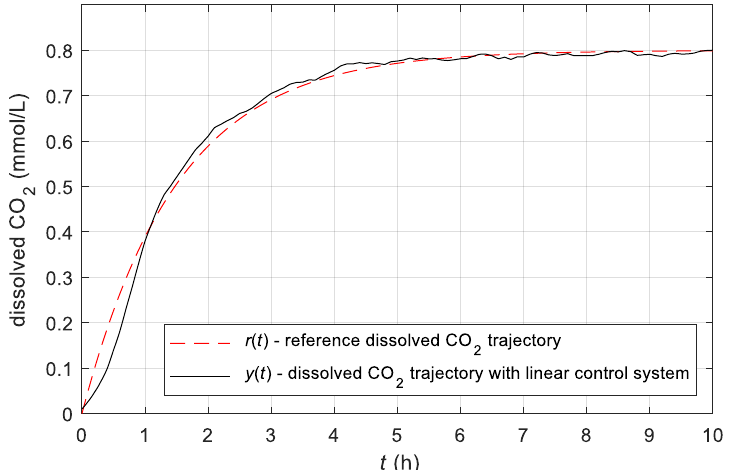
Figure 6. Time responses of the reference and actual dissolved CO 2 concentration of the original fermentation process in the batch bioreactor; the conventional control system with the linear controller with calculated parameters was used; data of the controlled original fermentation process with fully activated kefir grains are shown in Table 2; the controller parameters are shown in (22).